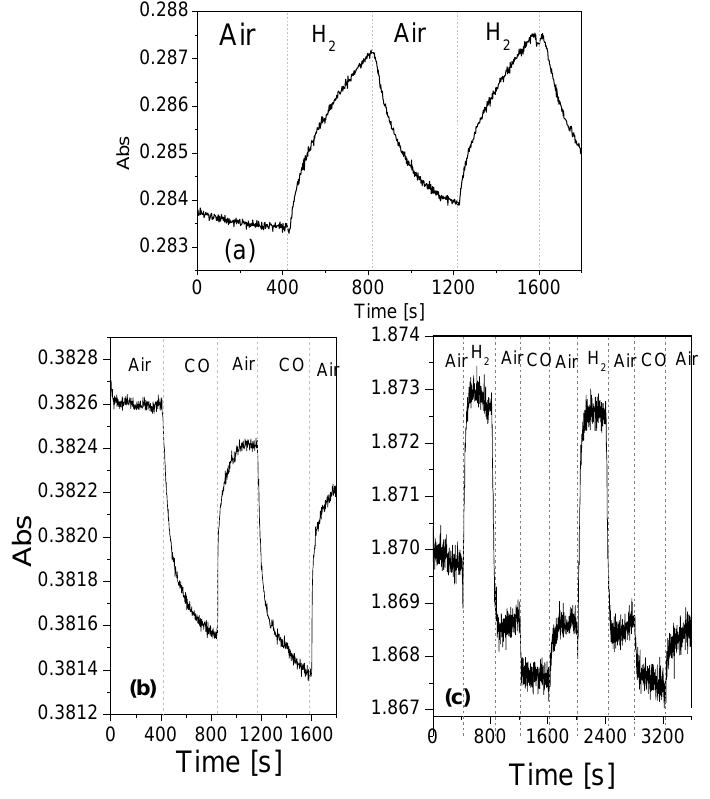
film operated at 3 operating the film at 2 and 1% v/v CO operating the film at 423 2